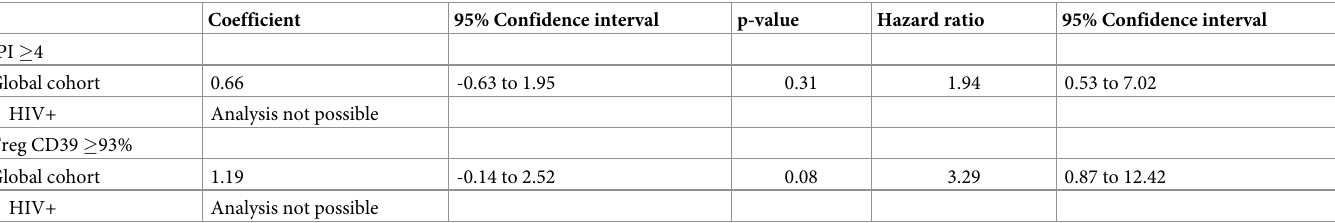
Table 9. Cox proportional-hazards regression analysis for independent associations between the survival time and the IPI and Treg expression of CD39. Coefficient